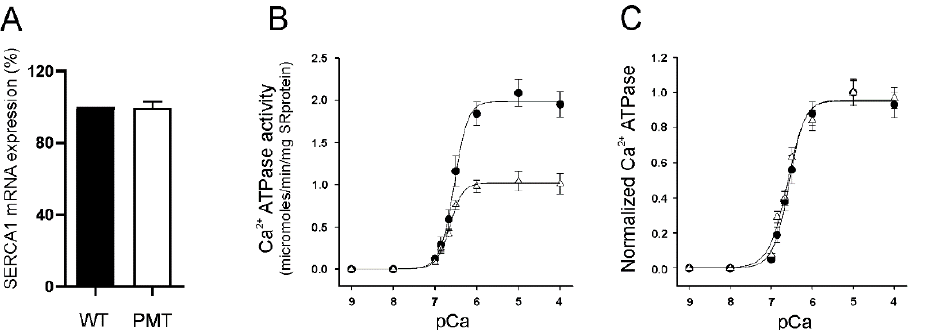
Figure 3. Expression levels of SERCA1 mRNA and calcium-dependent ATPase activity in controls and PMT-affected muscles carrying G211V/G286V SERCA1 mutations. ( A ) SERCA1 mRNA expression levels in healthy control (WT) and PMT-affected (PMT) calf muscles were quantified by RT-PCR. Data are reported as the relative expression relative to control muscles. Data were obtained from different mRNA extractions from the same pathological muscle specimen and are reported as the mean expression values ± SD. ( B ) The Ca 2+ -dependent ATPase activity was evaluated using an enzyme-linked ATPase assay performed on SR microsomes isolated from homozygous G211V/G286V Romagnola PMT calf and from unaffected Romagnola muscle specimens. The Ca 2+ sensitivity of the homozygous PMT calf was comparable with that of the WT. Data, expressed as micromoles/min/mg SR protein, are the mean ± S.D. Symbols: black circle: control animals; white triangle: G211V/G286V PMT-affected calf. ( C ) The specific ATPase activity was normalized based on the relative content of SERCA1 protein calculated by densitometric measurements conducted on immunoblots. Symbols: black circle: control animals; white triangle: G211V/G286V PMT-affected calf.